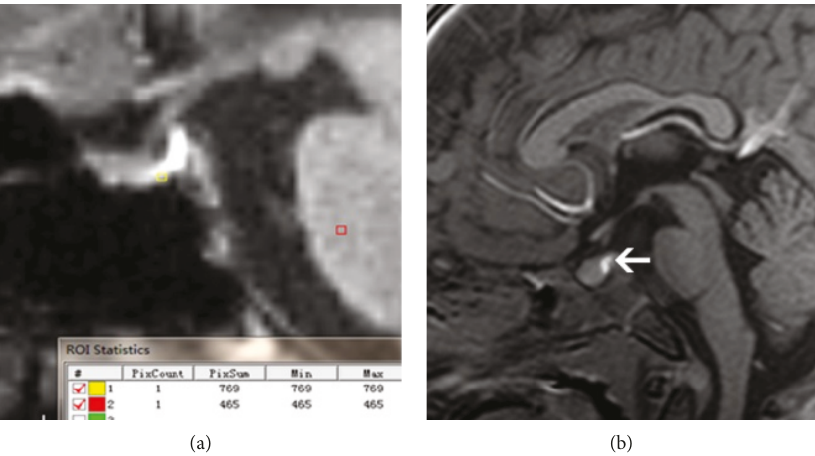
Figure 2: Measurement of the posterior pituitary signal intensity. (a) The signal intensity of the posterior pituitary of the normal pituitary was higher than that of the pons. (b) The high signal of the posterior pituitary (white arrow) contrasts with the anterior pituitary and the